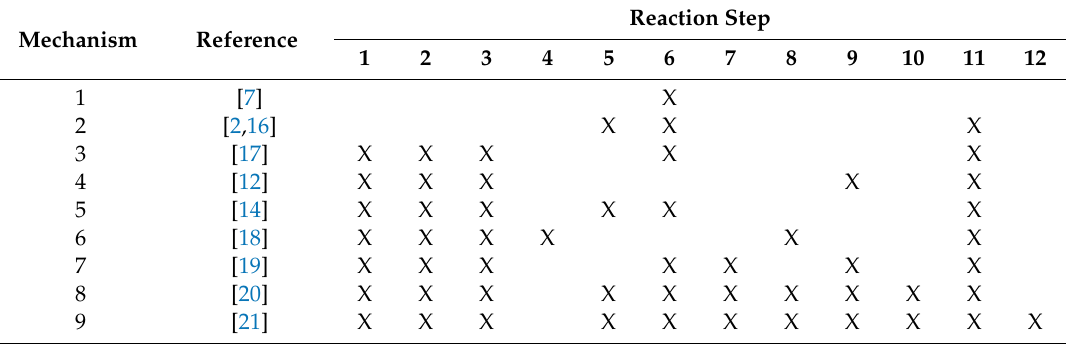
X: Reaction step from Figure 1.